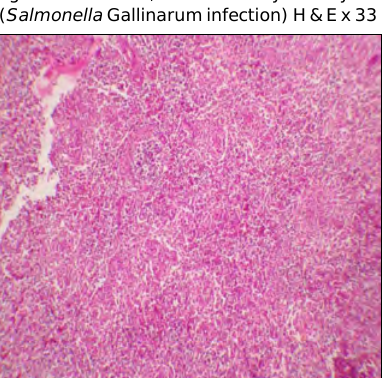
Figure-4. Necrotic nodule on heart ( Salmonella Gallinarum infection)